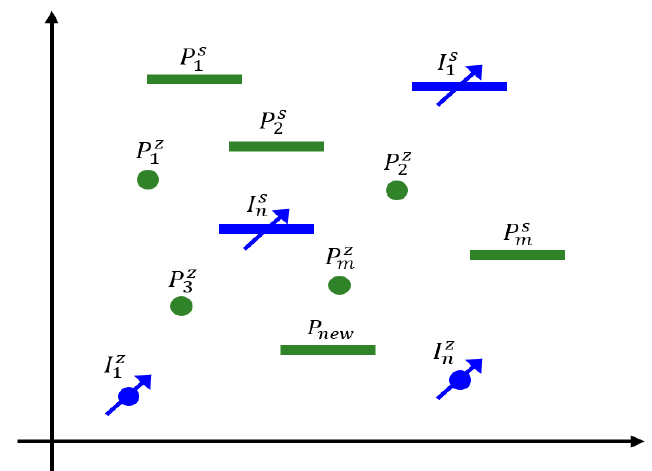
Figure 1. The deployment of mixed horizontal-vertical well pattern.